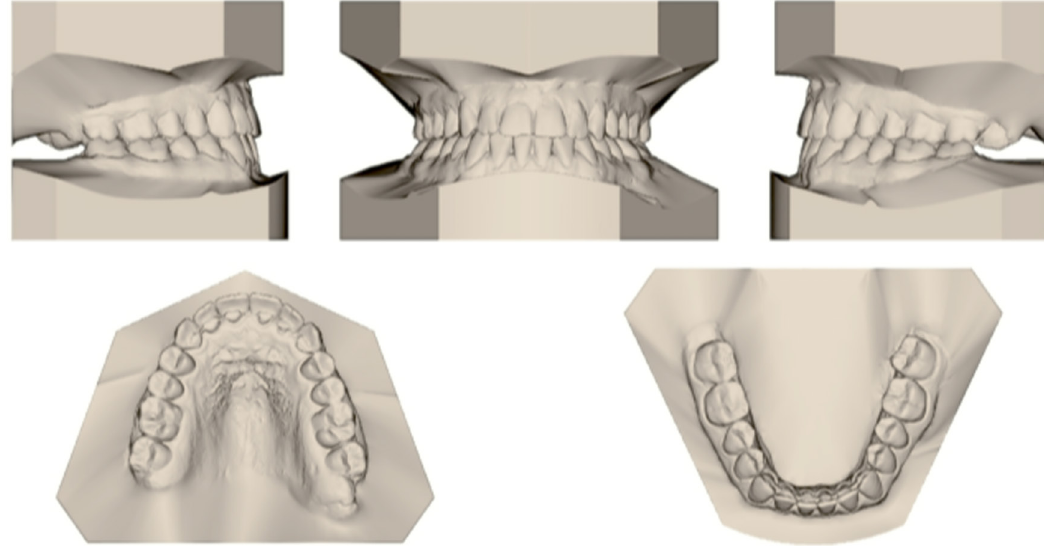
Figure 11. Post-treatment dental casts.